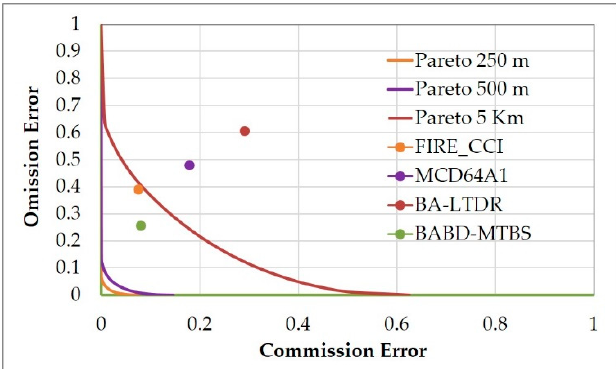
Figure 5. Pareto boundaries (250 m, 500 m and 5 km) of burned area in the Alaska region, and commission and omission errors for the period 1984–2015 for the Burned Areas Boundaries Dataset—Monitoring Trends in Burn Severity (BABD-MTBS), the Fire Climate Change Initiative (Fire_CCI) version 5.1, Moderate Resolution Imaging Spectroradiometer (MODIS) Direct Broadcast Monthly Burned Area Product Collection 6 (MCD64A1 C6), and burned area product from Long Term Data Record (BA-LTDR).